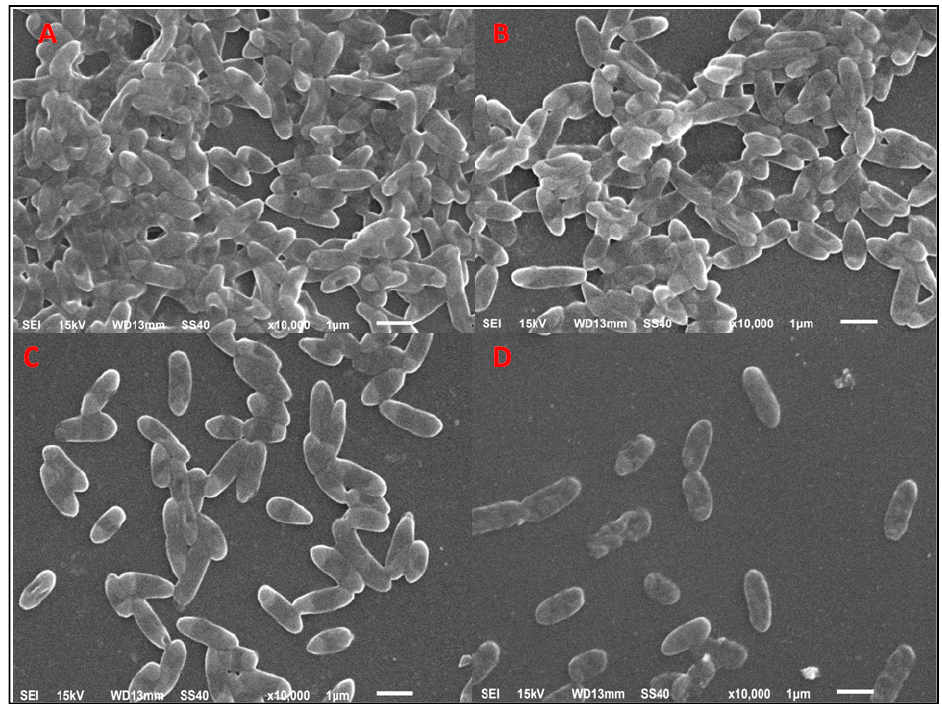
Figure 5. Scanning electron microscopic analysis of biofilm structure. SEM images of the biofilms formed on the glass coverslips after 24 h of incubation. ( A ) Control; ( B ), ( C ), and ( D ) treated with 50, 100, and 150 µg/mL of Tinospora cordifolia (TC)-AuNPs, respectively.